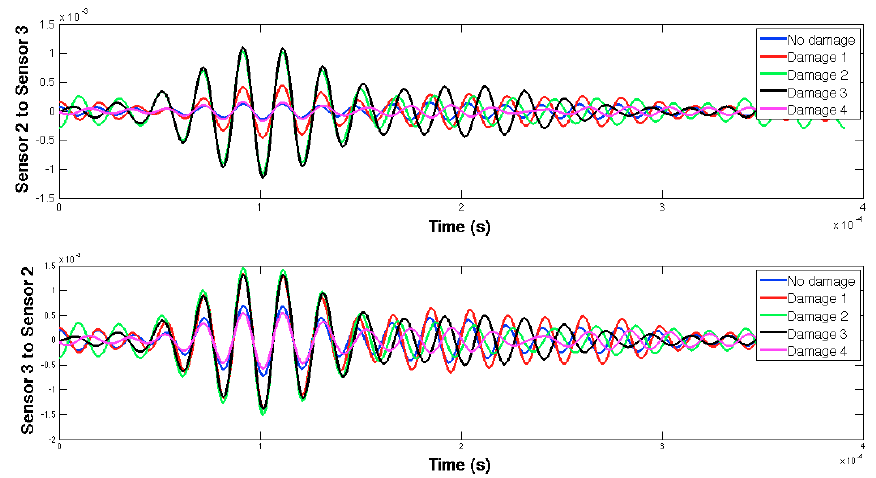
Figure 21. EMPD at 50 kHz. Tone-burst sent and measured between sensors 2 and 3. Sensors 2016 , 16 , 639